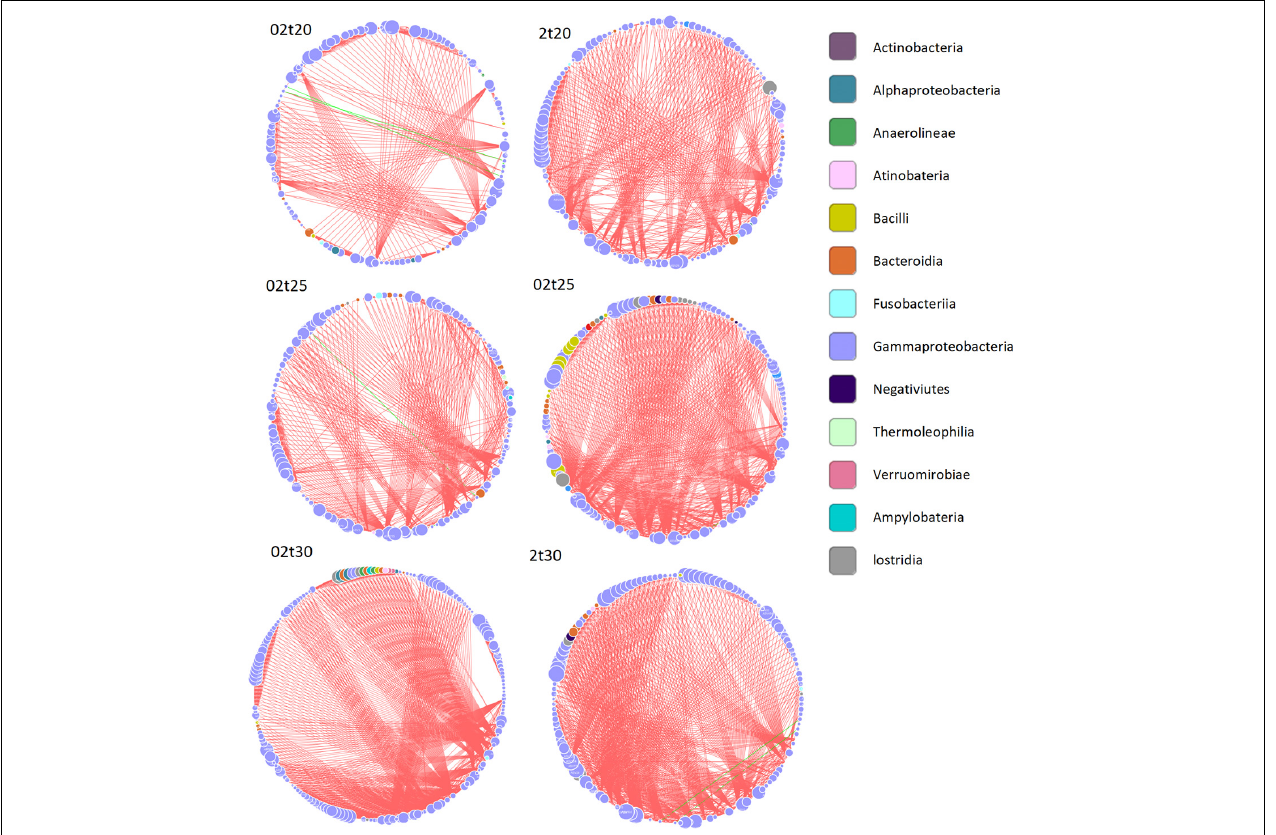
FIGURE 8 | Network analysis of bacterial interaction at different temperatures (02t20: free-living bacteria at 20 ◦ C; 02t25: free-living bacteria at 25 ◦ C; 02t30: free-living bacteria at 30 ◦ C; 2t20: attached bacteria at 20 ◦ C; 2t25: attached bacteria at 25 ◦ C; and 2t30: attached bacteria at 30 ◦ C). Each node represents an ASV. Node color represents taxon on class level. Green lines represent negative correlation, and red lines represent positive correlation between ASVs. The size of node indicates the number of links with other ASVs. The big nodes have more links with other ASVs. TABLE 1 | Topological properties of interaction networks under different conditions (02t20: free-living bacteria at 20 ◦ C; 02t25: free-living bacteria at 25 ◦ C; 02t30: free-living bacteria at 30 ◦ C; 2t20: attached bacteria at 20 ◦ C; 2t25: attached bacteria at 25 ◦ C; and 2t30: attached bacteria at 30 ◦ C). Groups Nodes Edges Positive Negative Modularity Average Average Network Average Graph interaction interaction clustering path diameter degree coefficient length